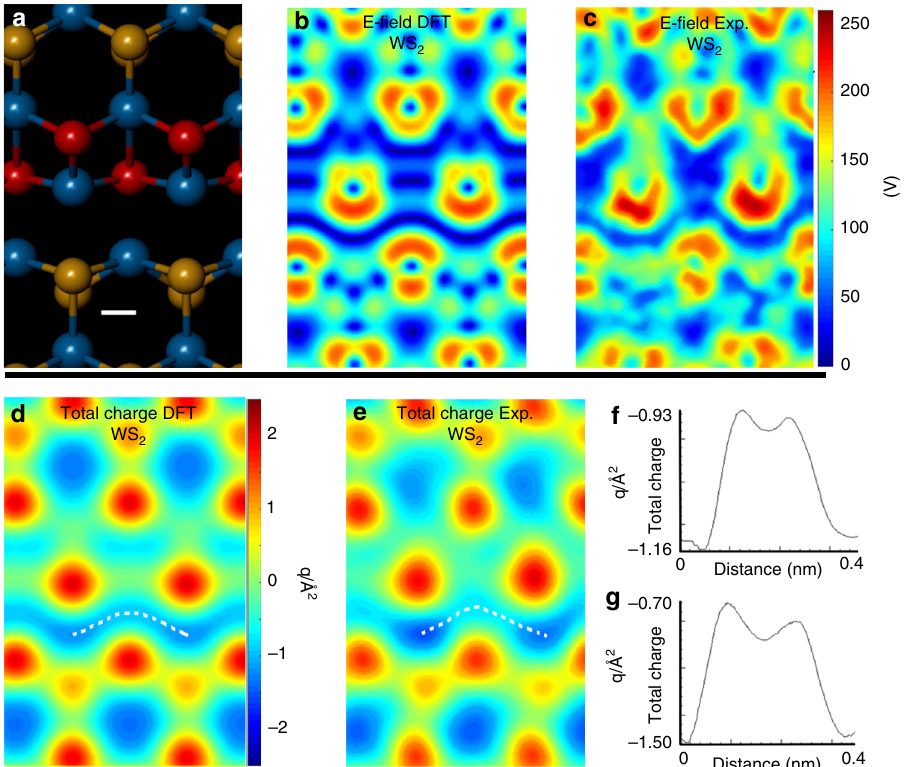
Fig. 4 High-resolution analysis of electric fi eld and total charge around a 1D line vacancy in WS 2 . a Atomic model of the W − W bonding region at WS 2 line defects (scale bar indicates 0.1 nm and is applicable to panels ( a – e )). b | E ┴ | map calculated using DFT and c experimental | E ┴ | map for WS 2 . d Total charge map for WS 2 from the atomic model in panel ( a ), calculated from DFT. e Corresponding experimental total charge map. f Line pro fi le taken along the white dotted line in d , from left to right, and g line pro fi le taken along the white dotted line in e , from left to right